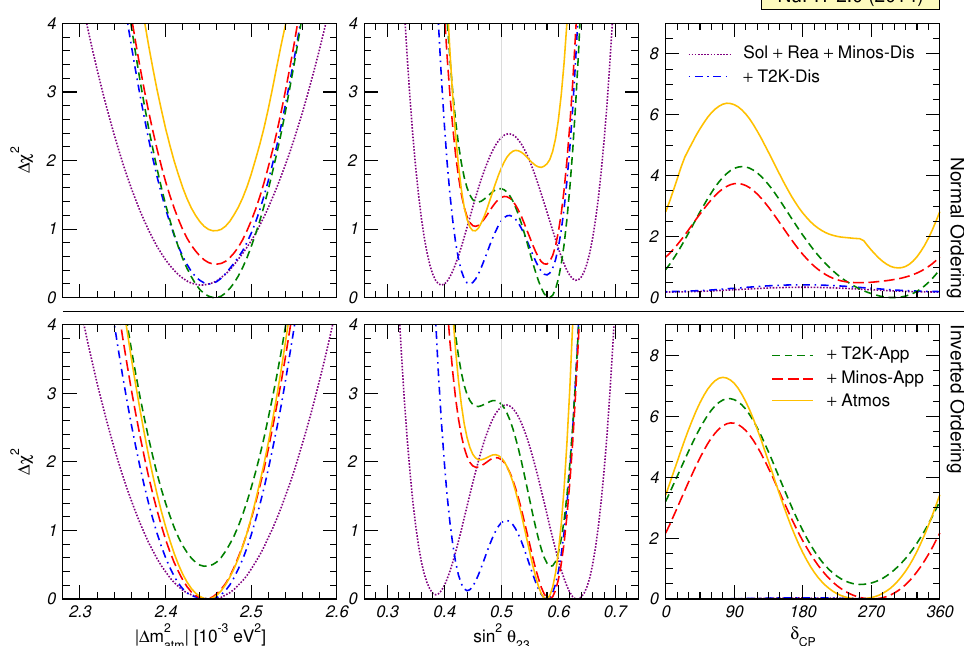
Figure 4. Contribution of different sets of experimental data included in NuFIT 2.0 to the determi- nation of mass ordering, octant of θ 23 , and CP violating phase. Left (right) panels are for IO (NO). Atmos is our analysis of SK1–4 (including SK4 1775-day) combined data. Figure adapted from